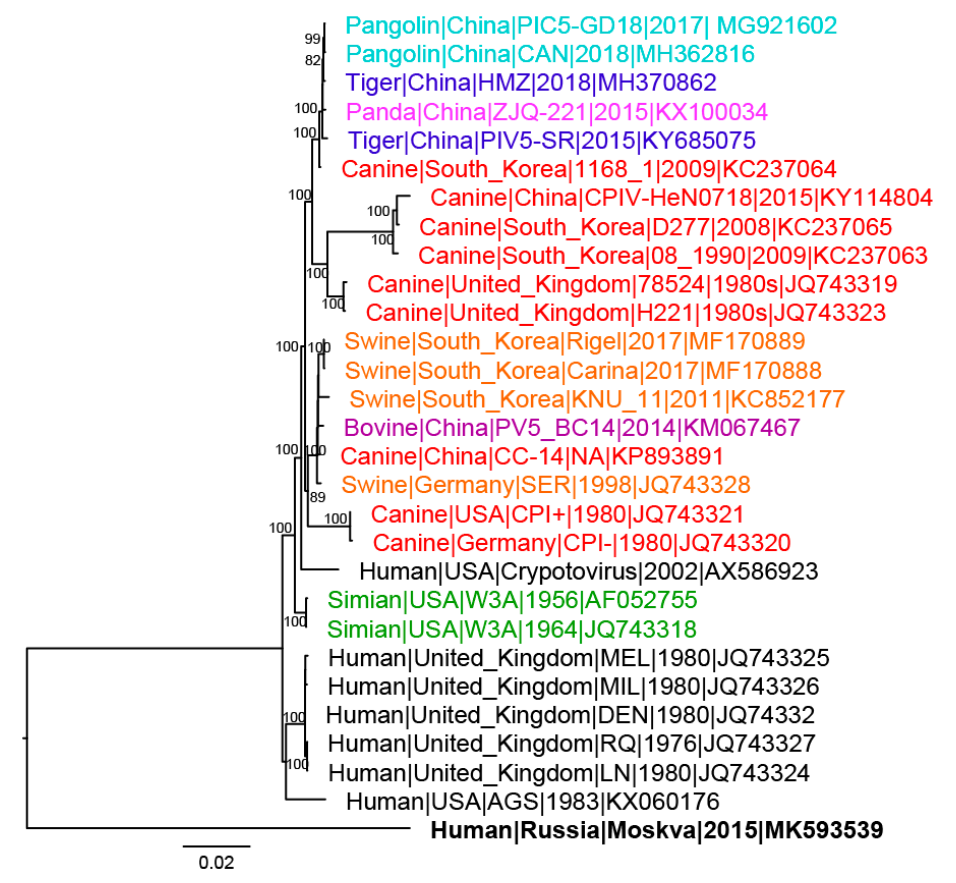
Figure 2. Whole genome phylogenetic tree of Mammalian orthorubulavirus 5 (PIV5) strains. Bootstrap values greater than 70 are shown at major nodes. Strains are colored according to host with black representing human strains; red, canine; orange, swine; green, simian; teal, pangolin; blue, tiger; pink, panda; and purple, bovine. Moskva is in bold.